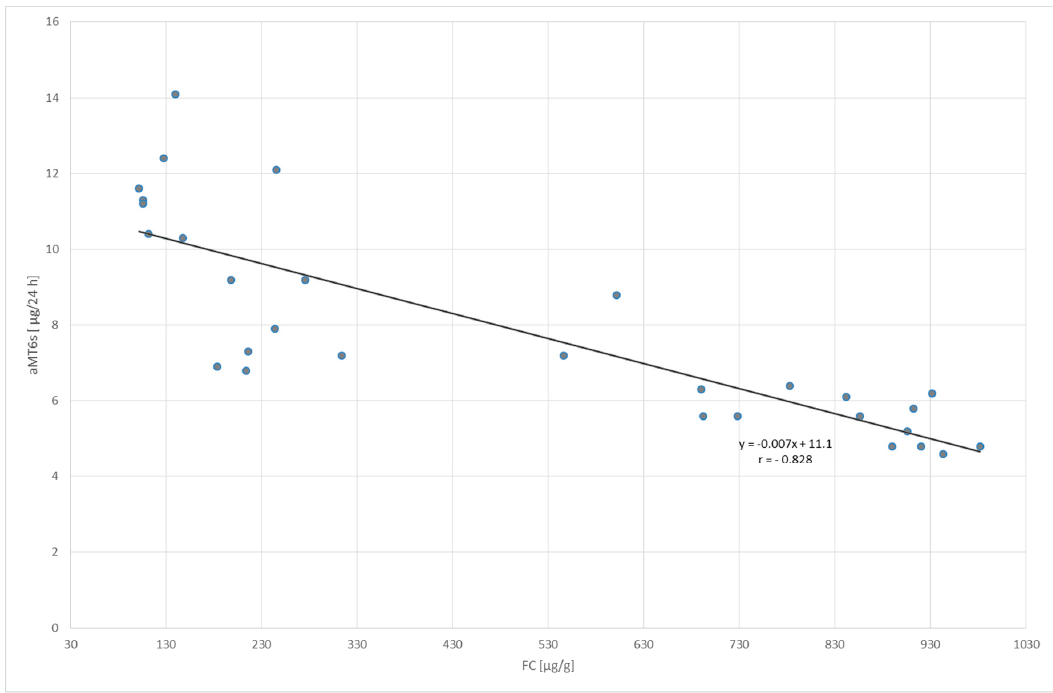
Figure 6. Correlation between fecal calprotectin (FC) concentration and urinary 6-sulfatoxymelatonin (aMT6s) excretion in patients with ulcerative colitis; p < 0.001.